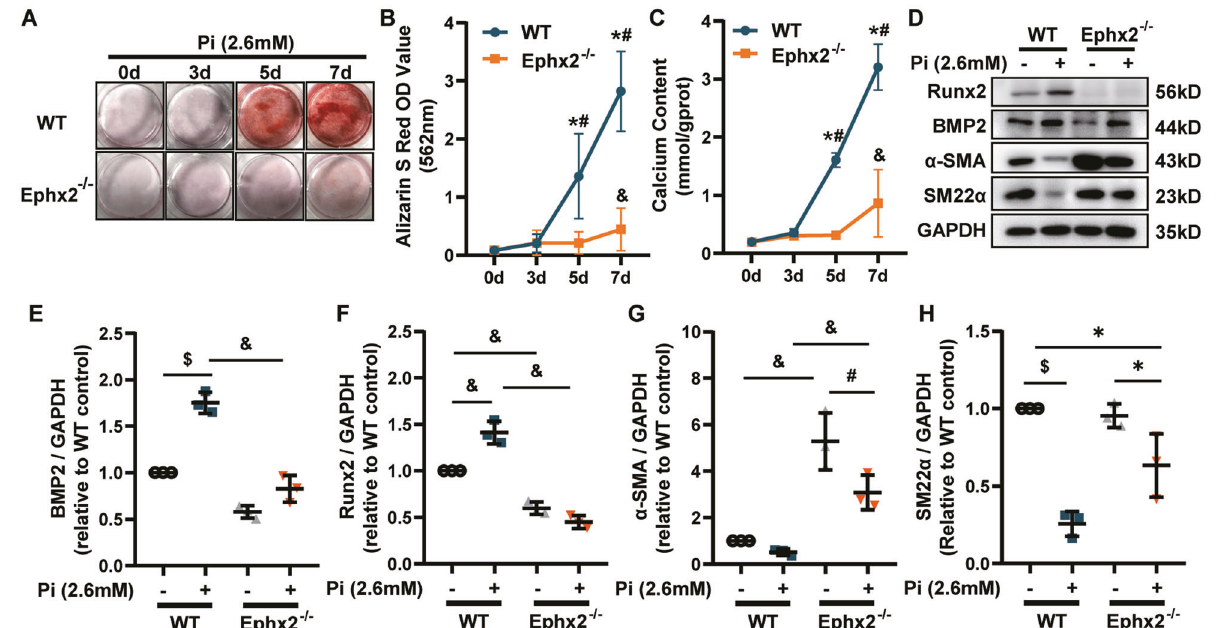
Fig. 2 Deletion of soluble epoxide hydrolase (sEH) ameliorated high phosphate (Pi)-induced vascular smooth muscle cell (VSMC) calcium deposition and phenotypic transition. A Alizarin Red S staining of VSMCs. B The related OD value (562 nm) of Alizarin Red S staining. C Quanti fi cation of calcium contents of VSMCs. The calcium contents of each group were normalized to the related protein concentrations. Data are presented as mean ± SD. * P < 0.05 vs. wild-type (WT) 0d; # P < 0.01 vs. WT 0 d; & P < 0.0001 vs. WT 0 d. D – H Representative western blot bands ( D ), and the quantitative analysis of bone morphogenetic protein-2 (BMP2) ( E ), runt-related transcription factor 2 (Runx2) ( F ), alpha smooth muscle actin ( α -SMA) ( G ), and smooth muscle 22 alpha (SM22 α ) ( H ) in VSMCs. Data are presented as mean ± SD. * P < 0.05; # P < 0.01; $ P < 0.001; & P <